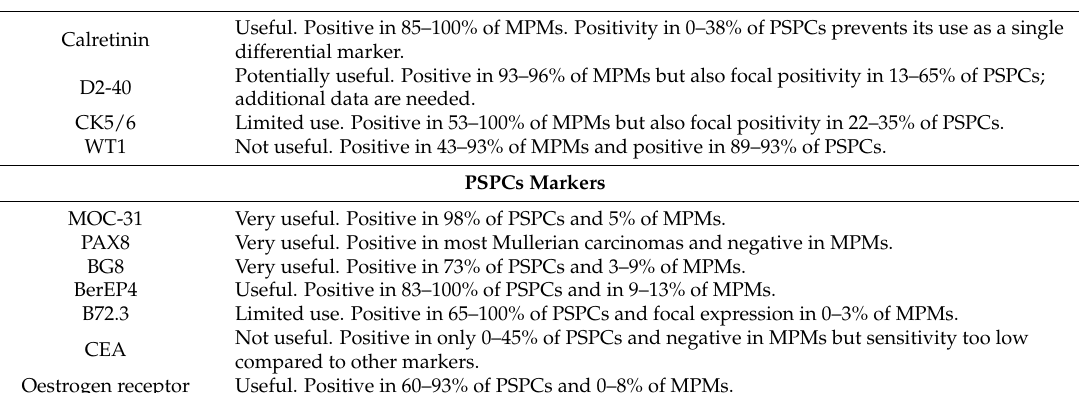
Table 3. Malignant peritoneal mesothelioma (MPM) versus papillary serous peritoneal carcinomas (PSPCs) and non-gynaecological adenocarcinomas (ADCs) [31,32]. Mesothelial Markers